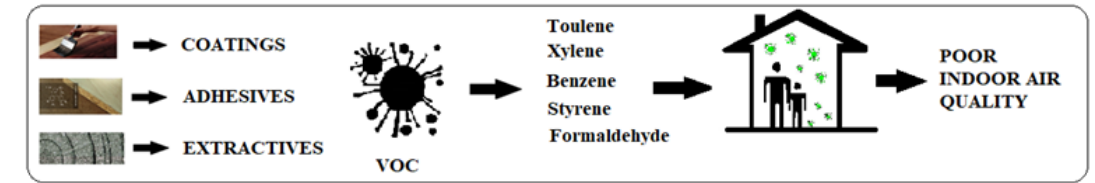
Figure 2. Volatile organic compounds (VOCs) from different types of furniture units .